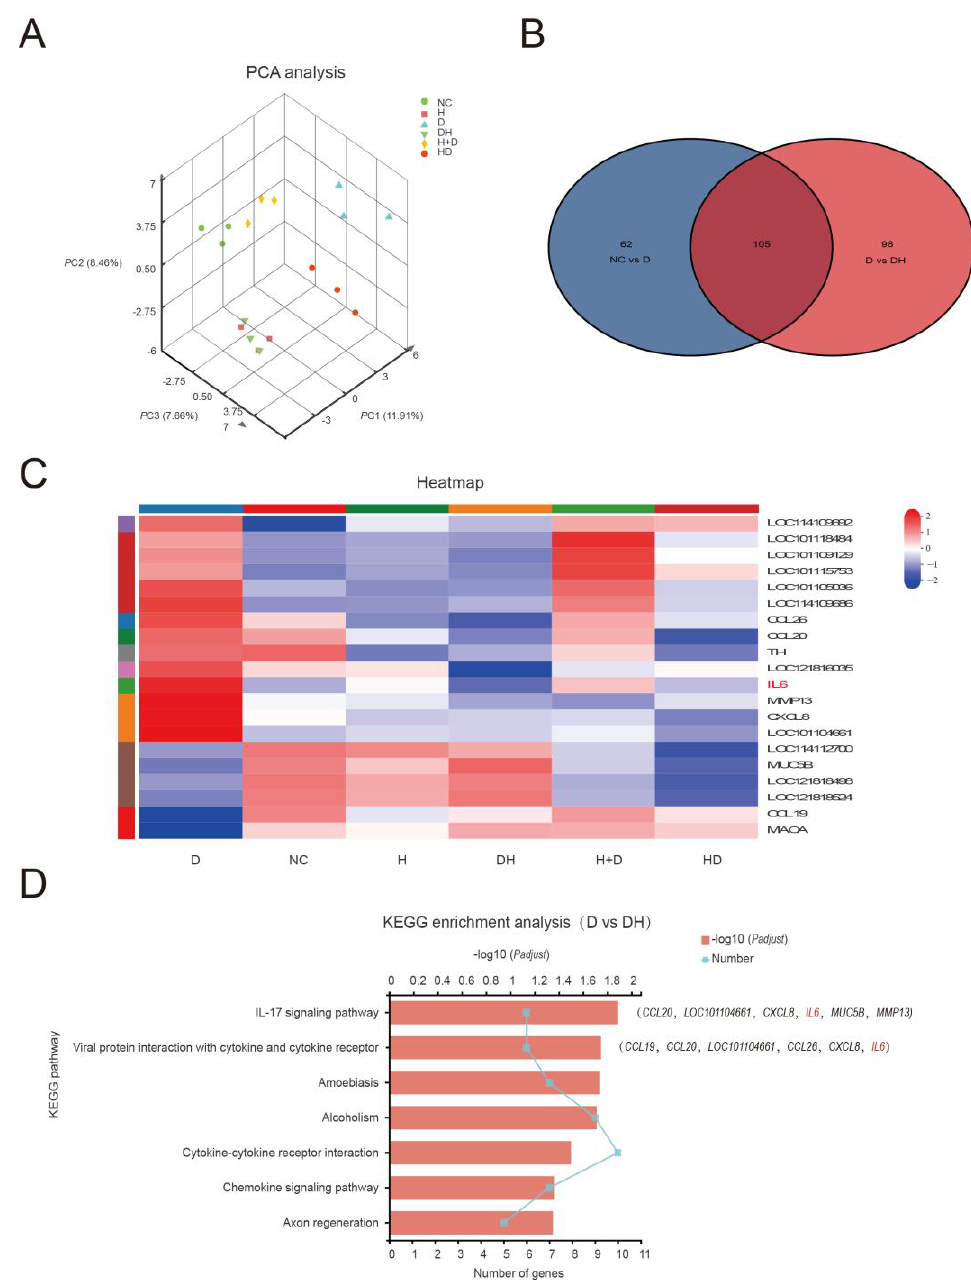
Figure 3. Transcriptomic analysis of the effect of HMB in the repair of myoblast injury. ( A ) PCA for the gene expression in myoblasts; ( B ) Venn diagram of NC, D and DH; ( C ) heatmap of top 20 differentially expressed genes; ( D ) KEGG enrichment analysis of the DEGs (D group vs. DH group; n = 3).